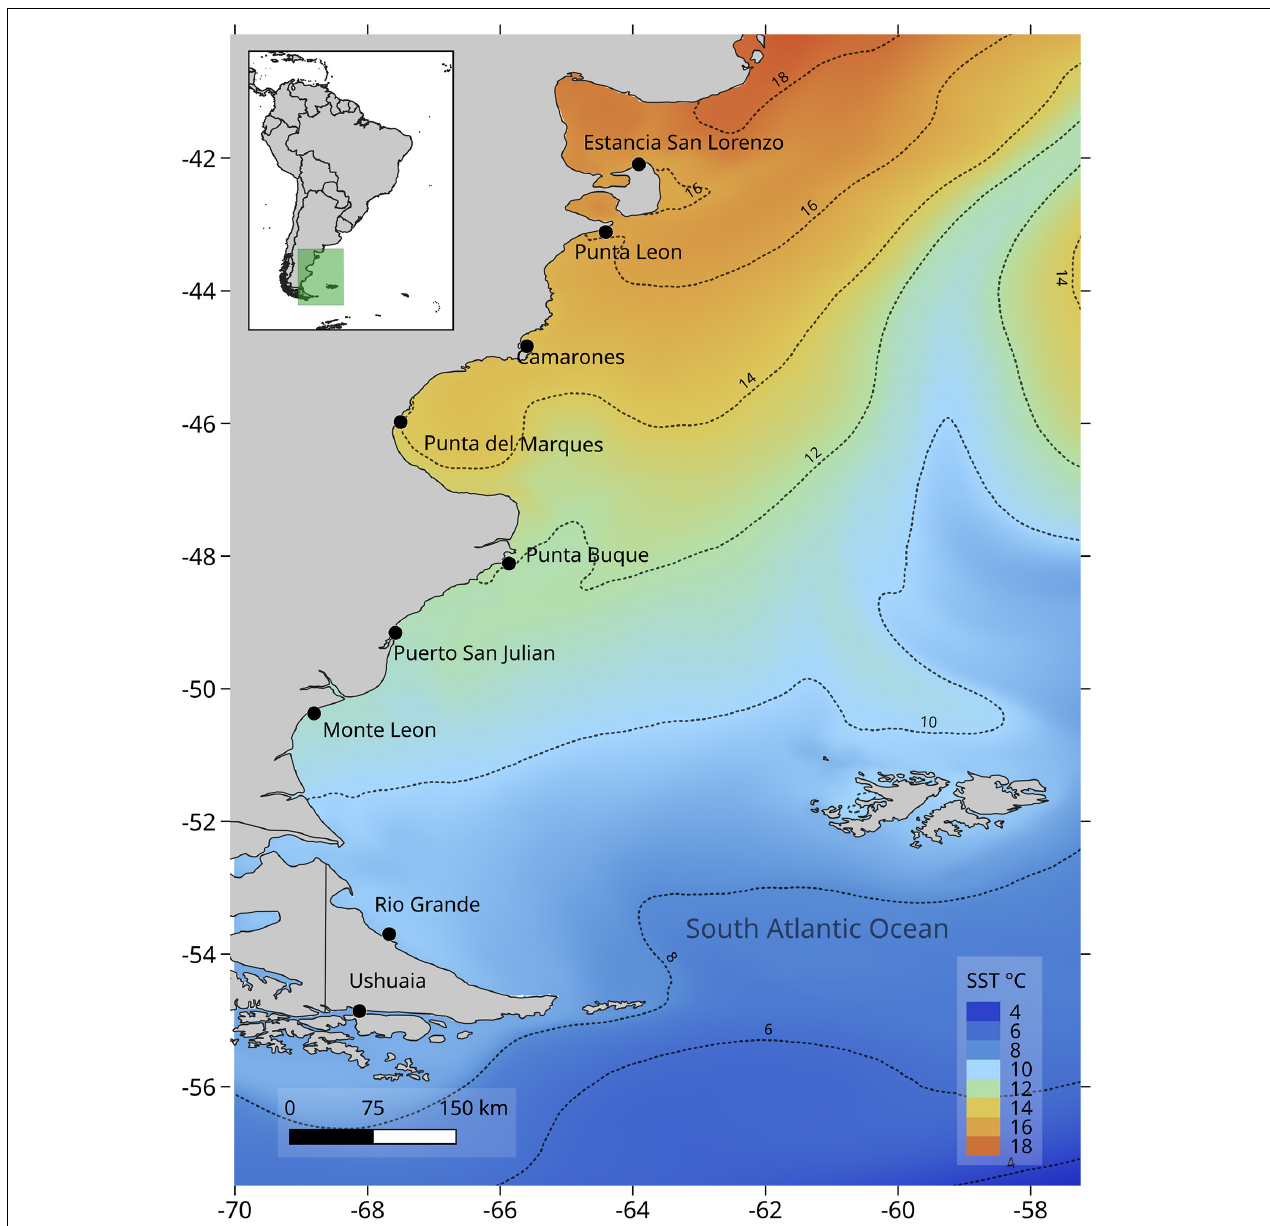
FIGURE 1 | Sampled locations in Atlantic Patagonia: Estancia San Lorenzo (ESL), Punta León (PLE), Camarones (CAM), Punta del Marqués (PMA), Punta Buque (PBU), Puerto San Julián (SJU), Monte León (MLE), Río Grande (RGR) and Ushuaia (USH). MUR SST mean climatological temperature for January–May. Source: